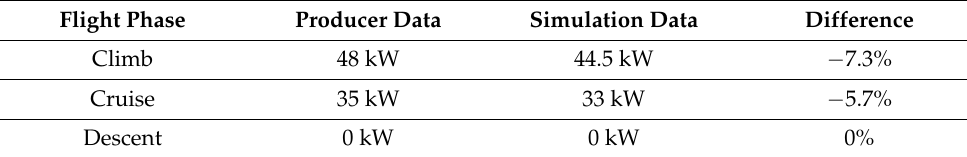
Figure 5. Typical flight profile with parameters of Pipistrel Velis Electro [45]. Table 7. Comparison of simulation results and producer